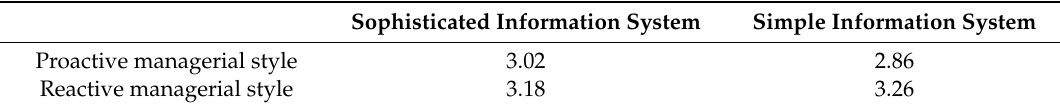
Table 5. ANOVA results: Mean scores for strategic goals towards cost saving (n =